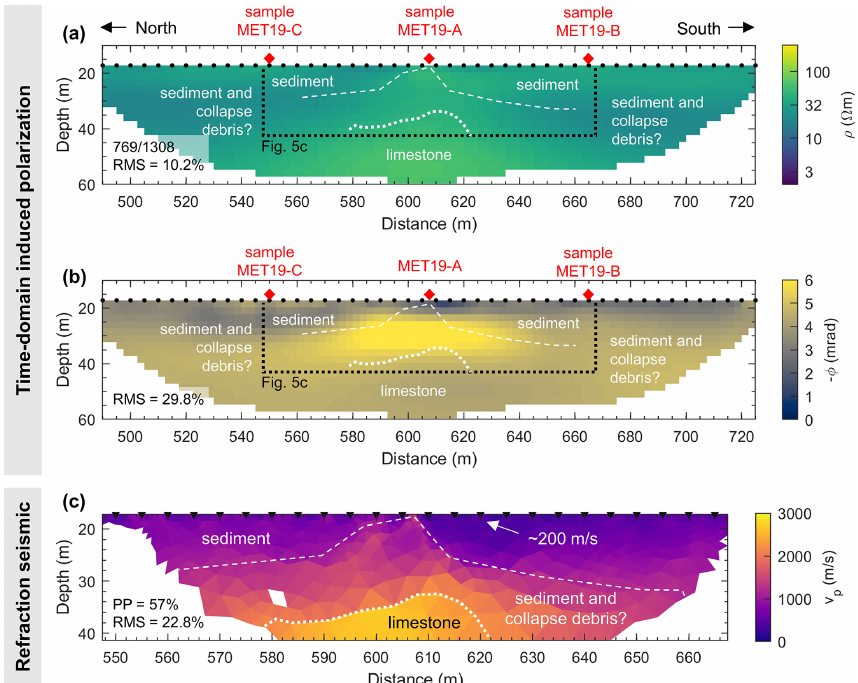
Figure 5. Geophysical sections along Profile 2 of Lake Metzabok (same coordinates as in Fig. 4): ( a and b ) electrical resistivity and phase images, respectively, including electrode positions (black dots along the surface), sampling locations of sediment samples (red diamonds at the surface), and the main lithological units interpreted from the SBP image (dotted lines). Labels in the lower-left corners represent the amount of data points used for the inversion compared to the total measured data (same for resistivity and phase) and the respective percentage root mean square (RMS) deviations of the inversion. (c) Seismic refraction tomogram with main lithological units including picking percentage (PP) and RMS of the